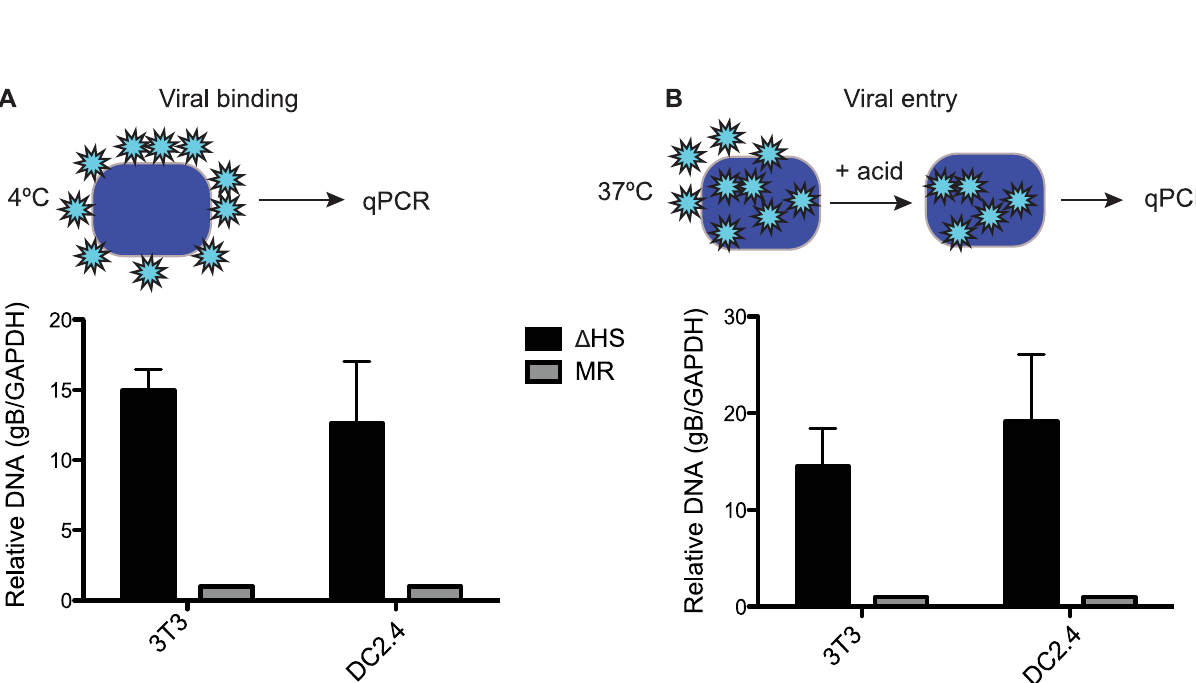
Top portion of the table are proteins identified in both D HS and MR samples for the first mass spectrometry (MS) run. Lower portion of the table is from the second MS run. The peptide count was normalized to major capsid protein ORF 25, and subsequently normalized to genome number, as determined by qPCR. a Genome number for first MS run. b Genome number for second MS run.